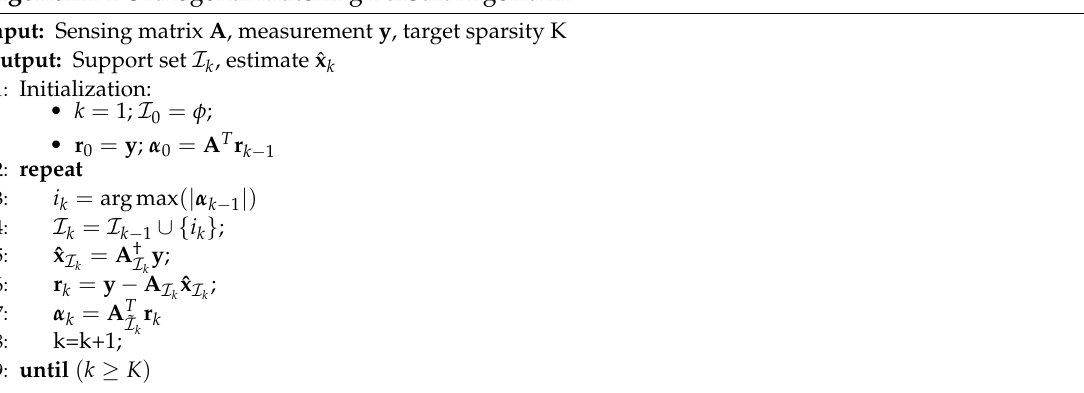
Algorithm 1 Orthogonal Matching Pursuit